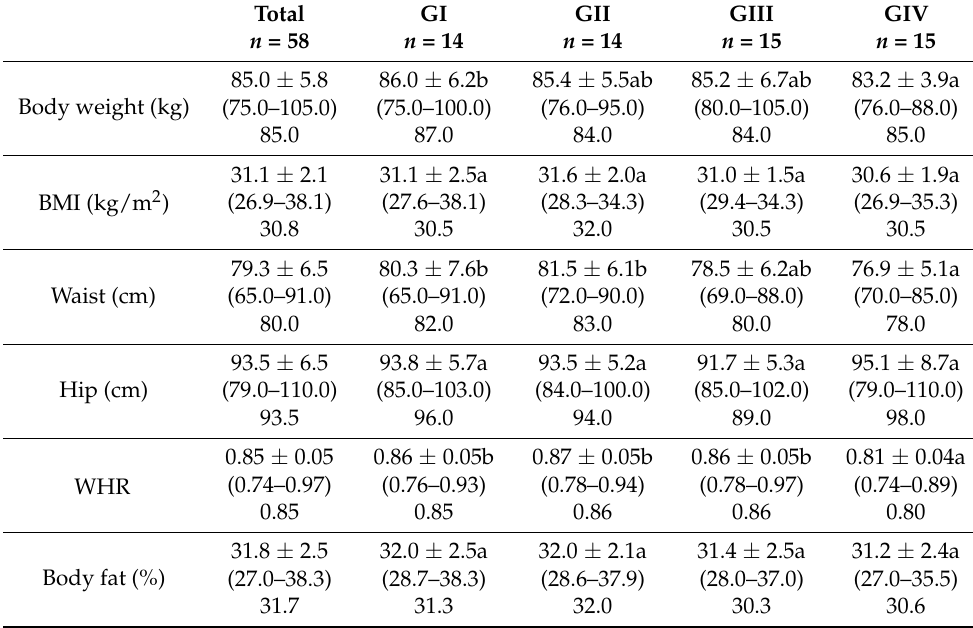
Table 2. The anthropometric parameters of subjects after six weeks of study (end of